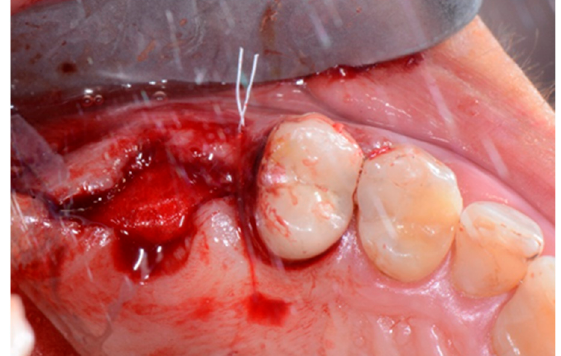
Figure 4. Alveolar socket filled with the graft material.